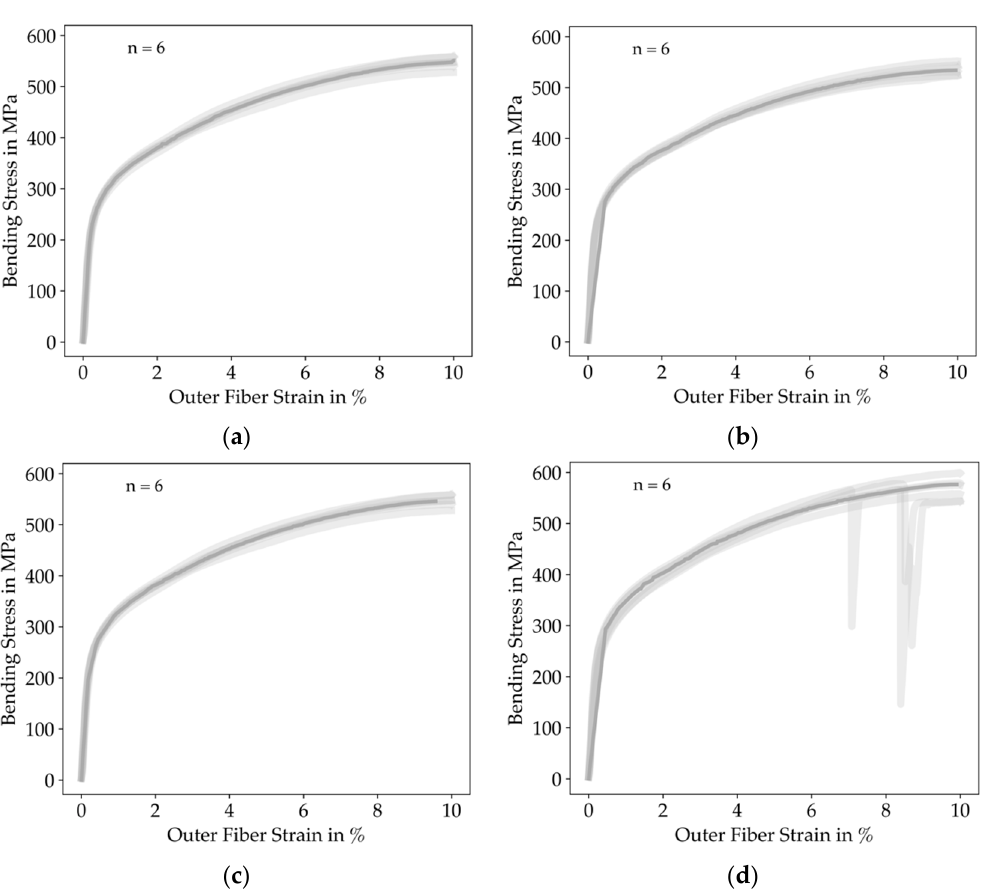
Figure 13. Resulting stress-strain curves of all tensile specimens clustered by infill degree. The solid line represents a mean-curve computed by rigid regression, the shaded lines represent the single measurements: ( a ) ID 25; ( b ) ID 50; ( c ) ID 75; ( d ) ID 100. The down-peaks in the ID 100 measurements were caused by the slipping of the specimens on the machine’s support. In general, the deviations between the various infill degrees are small.